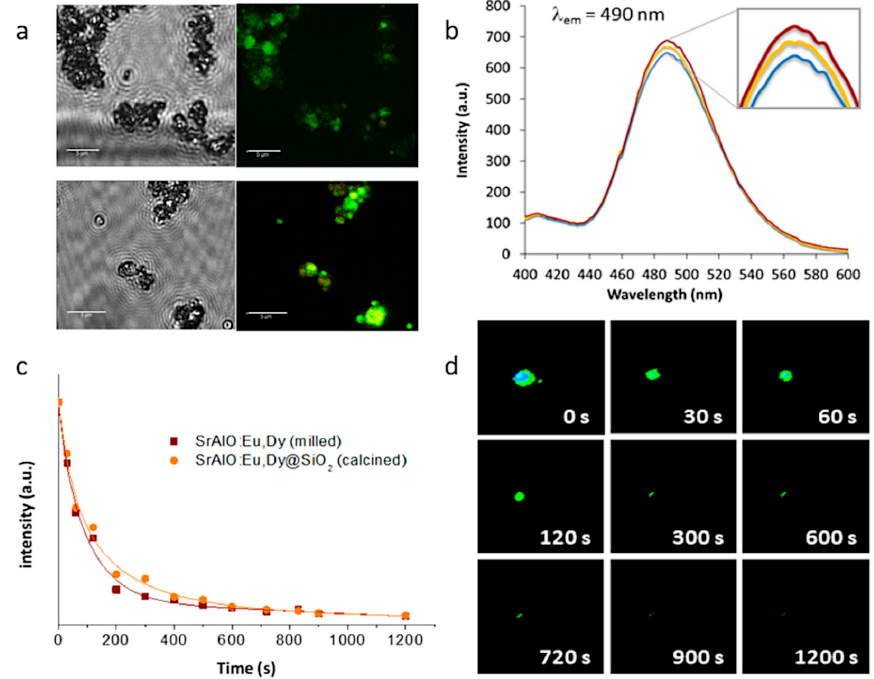
Figure 7. Optical performance of the SrAlO:Eu,Dy@SiO 2 core-shell composites. ( a ) Confocal fluores- cence micrographs corresponding to the as-prepared composites (top images) and after the calcination process at 400 °C (bottom images); measurements were performed in bright-field and green channel ( λ em = 500–550 nm); λ ex = 405 nm. Scale bar: 5 μ m. ( b ) Fluorescence emission spectra of the milled powder (red line), the as-prepared composites (blue line) and the consolidated material (yel- low line), upon excitation wavelength at 345 nm. ( c ) Afterglow curves for the persistent lumines- cence of the uncoated and SiO 2 -coated materials ( λ exc. = 345 nm, λ em. = 490 nm). ( d ) Time-lapse frames showing green long-lasting phosphorescence in the consolidated composites ( λ em = 510 nm).